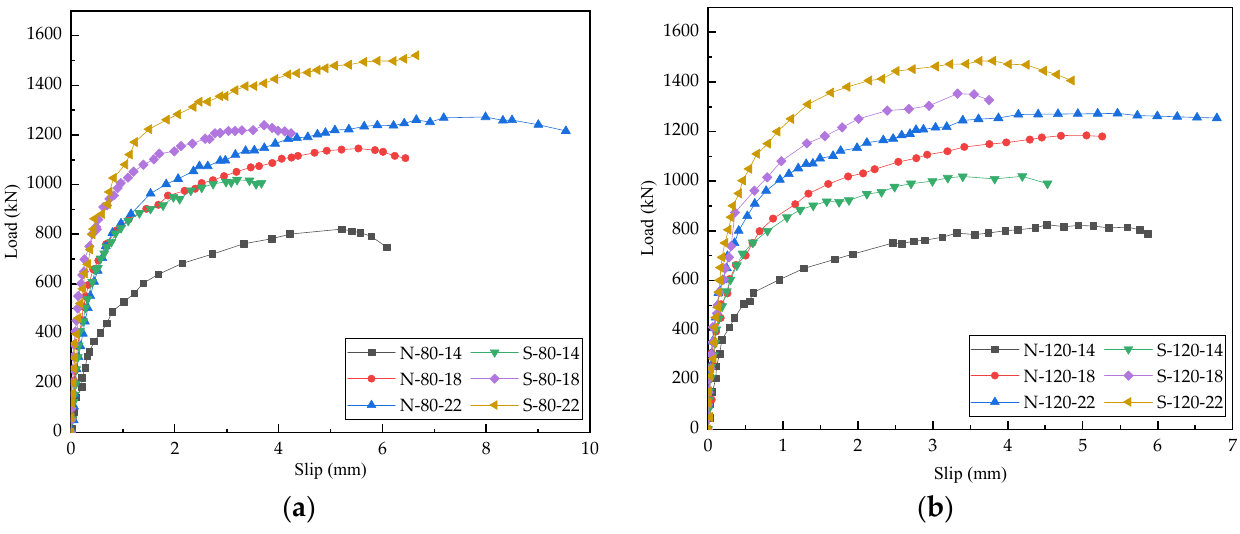
Figure 6. Load ‐ slip curves of different stud lengths: ( a ) 80 mm; ( b ) 120 mm. Figure 6. Load-slip curves of different stud lengths: ( a ) 80 mm; ( b ) 120